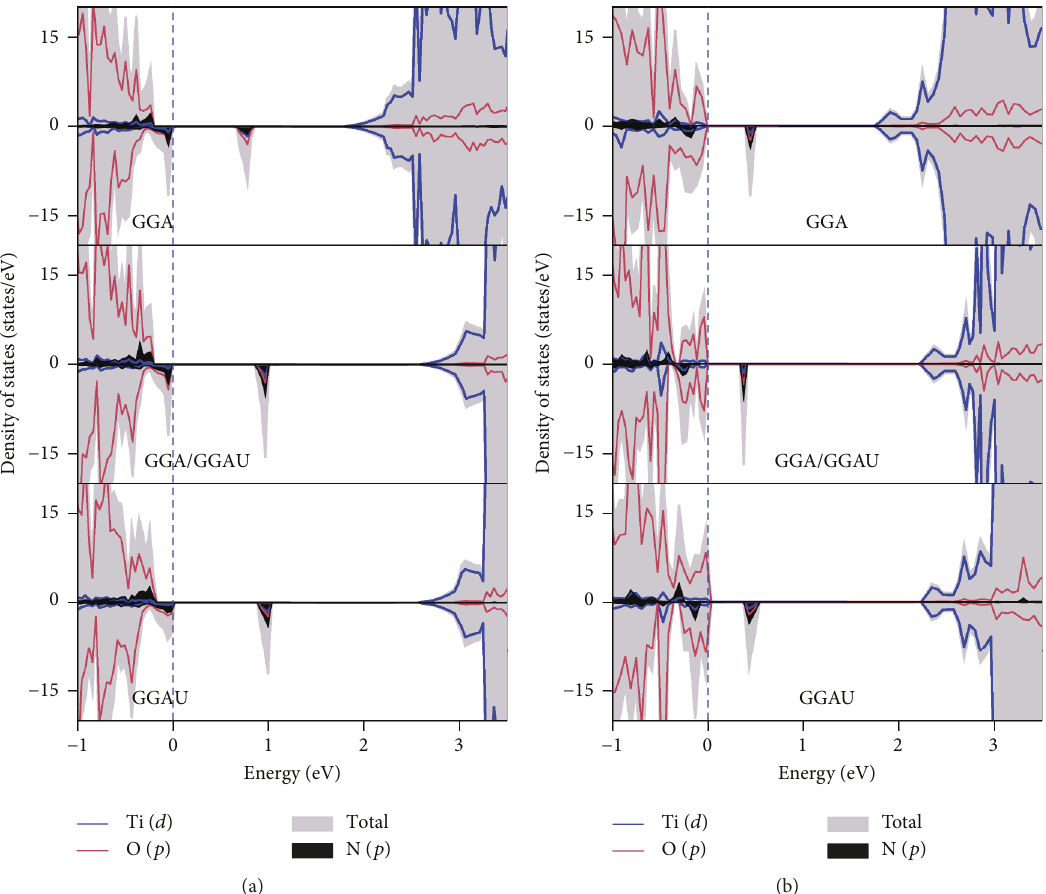
Figure 3: The total and partial density of states of the three relaxation methodologies for N-doped anatase TiO (b) The TiO (101) 2